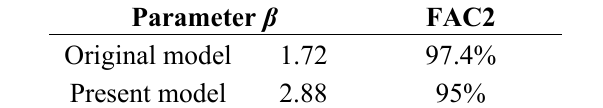
Table 2. C max model versus observation performance for Δτ / Δτ 0 = 1–2000.